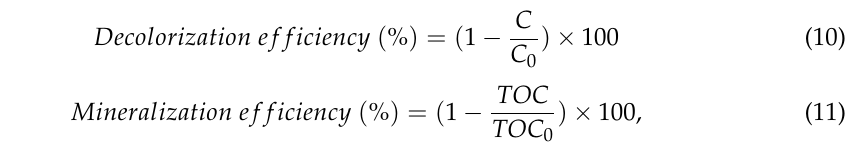
(c) 50 ◦ C. Other reaction conditions: 50 mg of catalyst, VPY = 250 mL, C0 = 30 ppm, initial pH = 3.00, CH2O2 = 12 mM; Figure S4: Relative Tar concentration, C/C0, as a function of time for FeMn-NaY (a) and MnFe-NaY for two cycles of reaction. Reaction conditions: 50 mg of catalyst, V Tar = 250 mL, C 0 = 30 ppm, initial pH = 3.00, H 2 O 2 = 12 mM, T R = 40 ◦